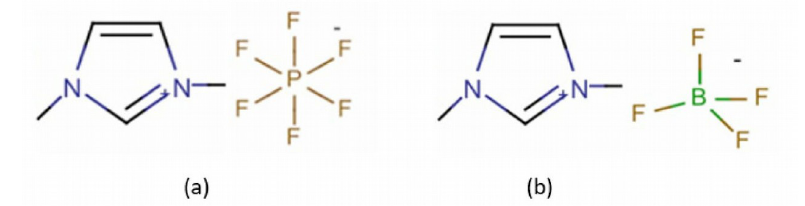
Figure 5. Ionic liquid salts with imidazolium